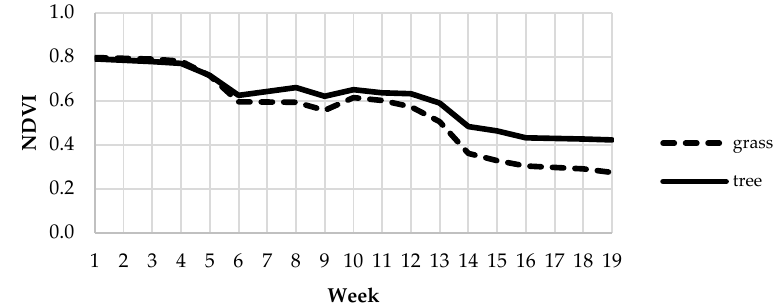
Figure 4. Evolution of NDVI for grass and tree pixels during the experimental period.